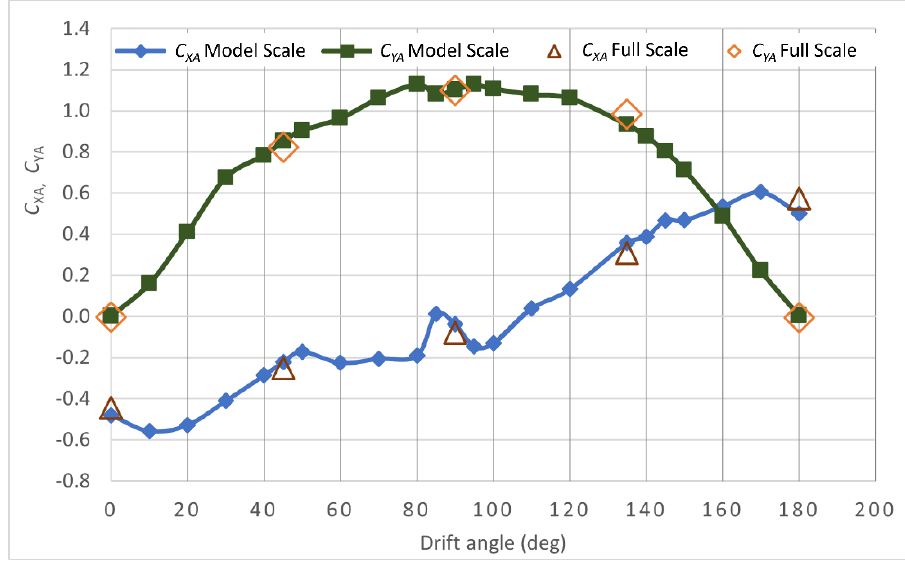
Figure 12. Surge and sway force coefficients (aerodynamic) for the Tejo class vessel. Relative comparison between the full-scale and model scale results (Figures 12 and 13) suggests that the non-dimensional force results agree quite well with each other. Alt- hough slight over-predictions are observed in the case of model scale results for surge force, sway force results agree very well. Relatively notable variations are observed in the case of moment prediction, especially at the 135° drift angle.